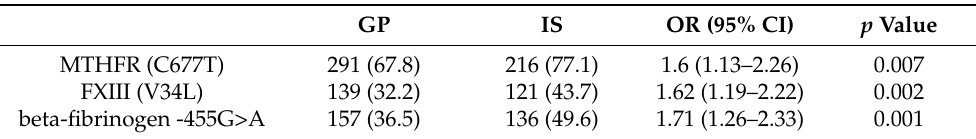
Table 4. Odds ratios (ORs) with the corresponding 95% confidence intervals (95% CIs) of some gene variants for ischemic stroke (IS n = 282) (GP, n = 430).